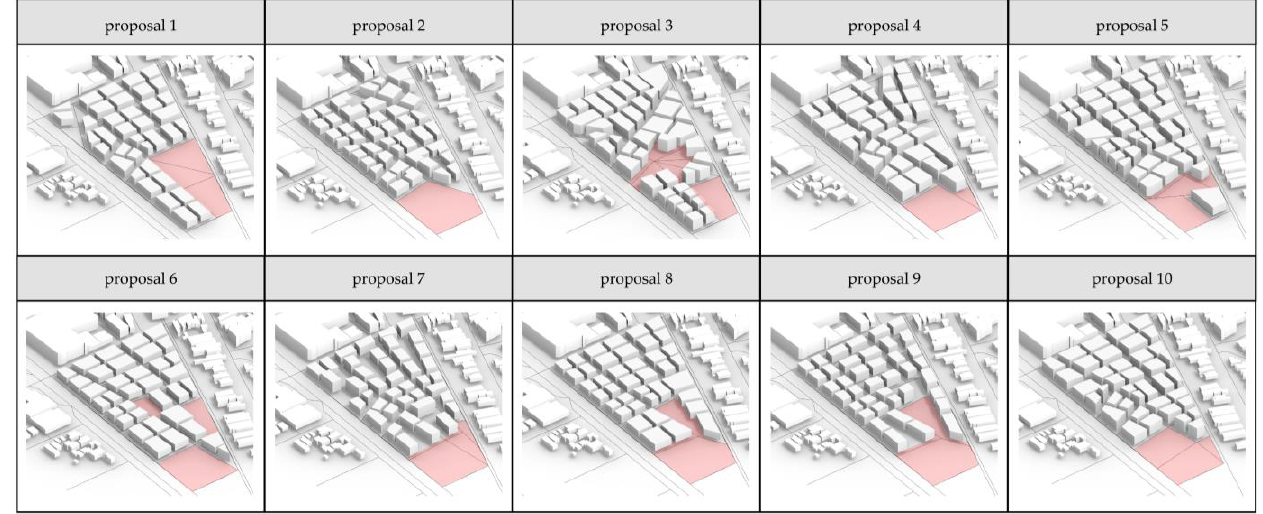
Figure 13. The public spaces in 10 representative urban design proposals.